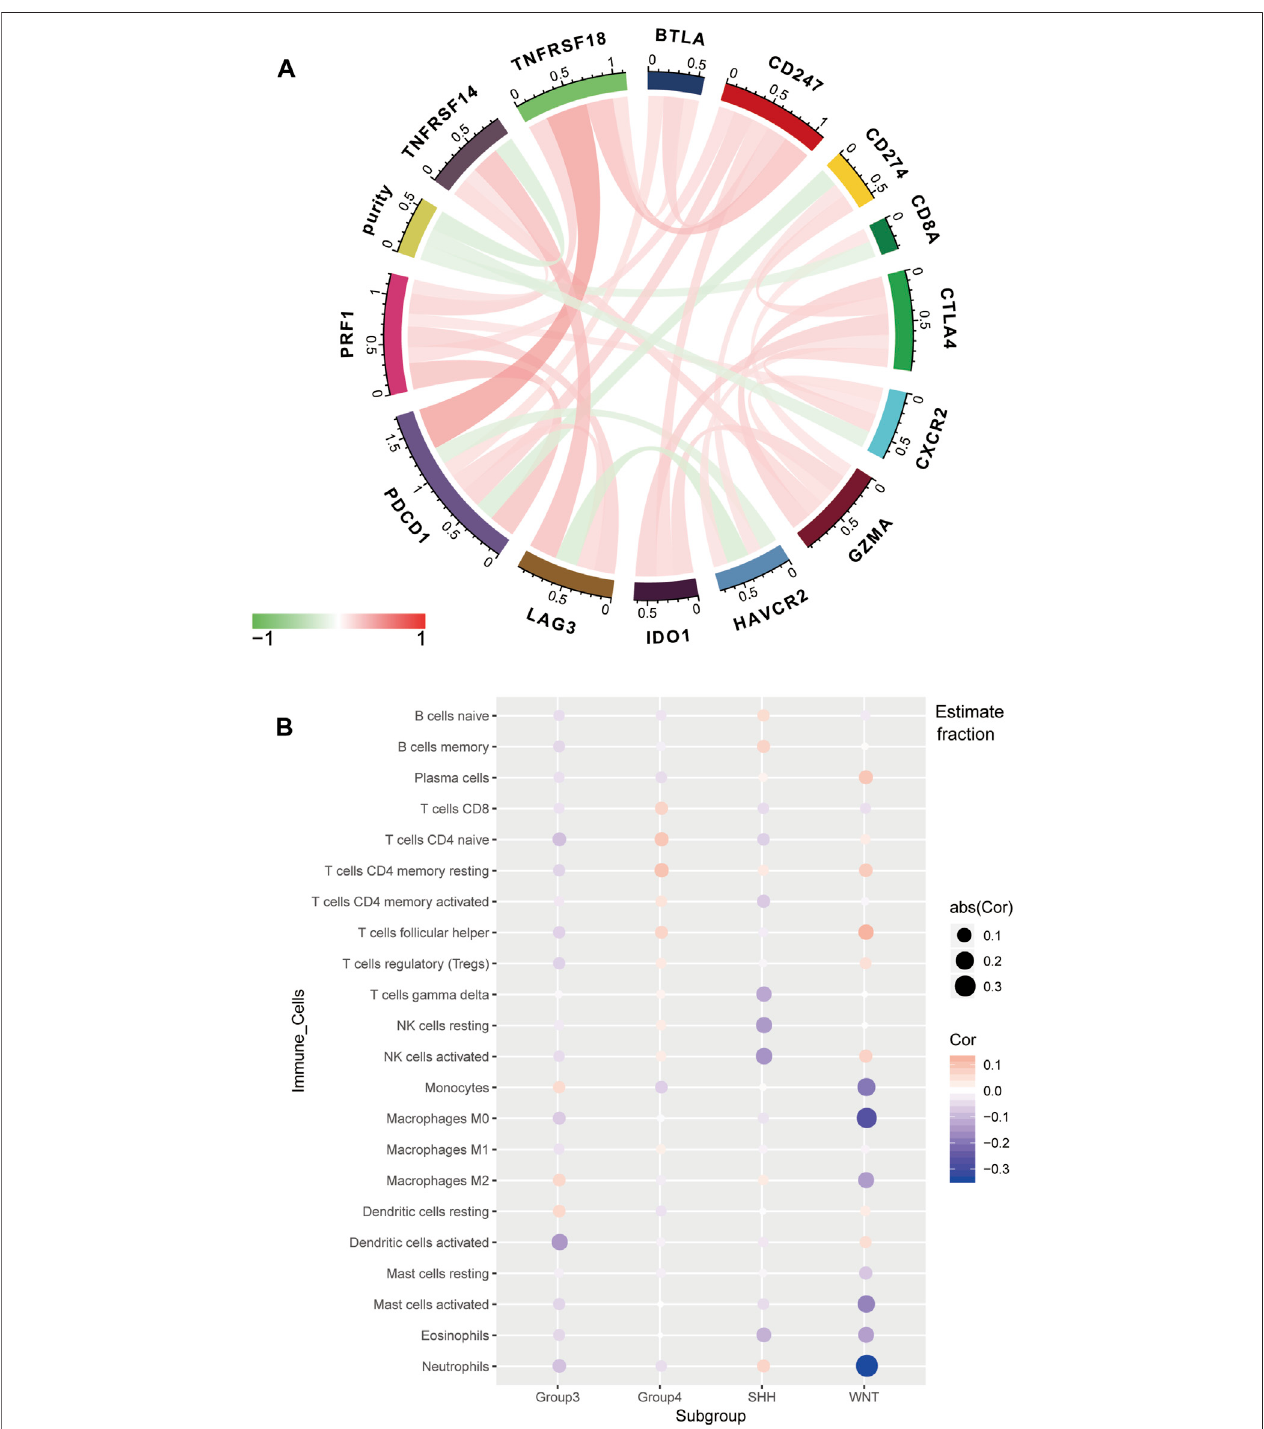
FIGURE 8 | Relationship between the purity of medulloblastoma (MB) and the immune microenvironment in the GSE85218 dataset. (A) Relationship between the MB purity and immune-related genes; (B) correlation between the purity of each MB subgroup and the CIBERSORT-based in fi ltrating immunocyte proportions.